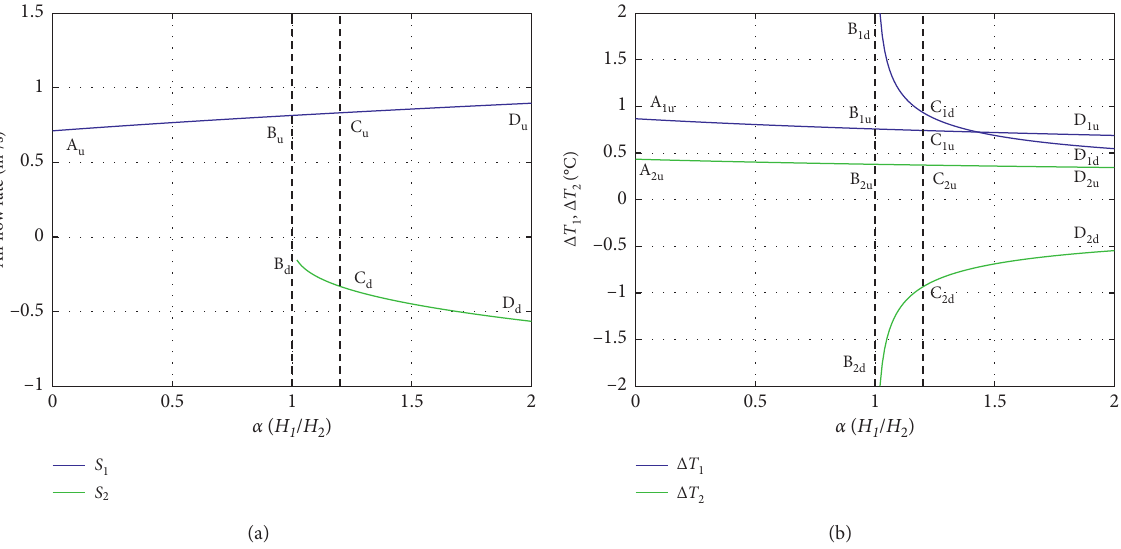
Figure 11: Bifurcation diagram. (a) Air flow rate. (b)